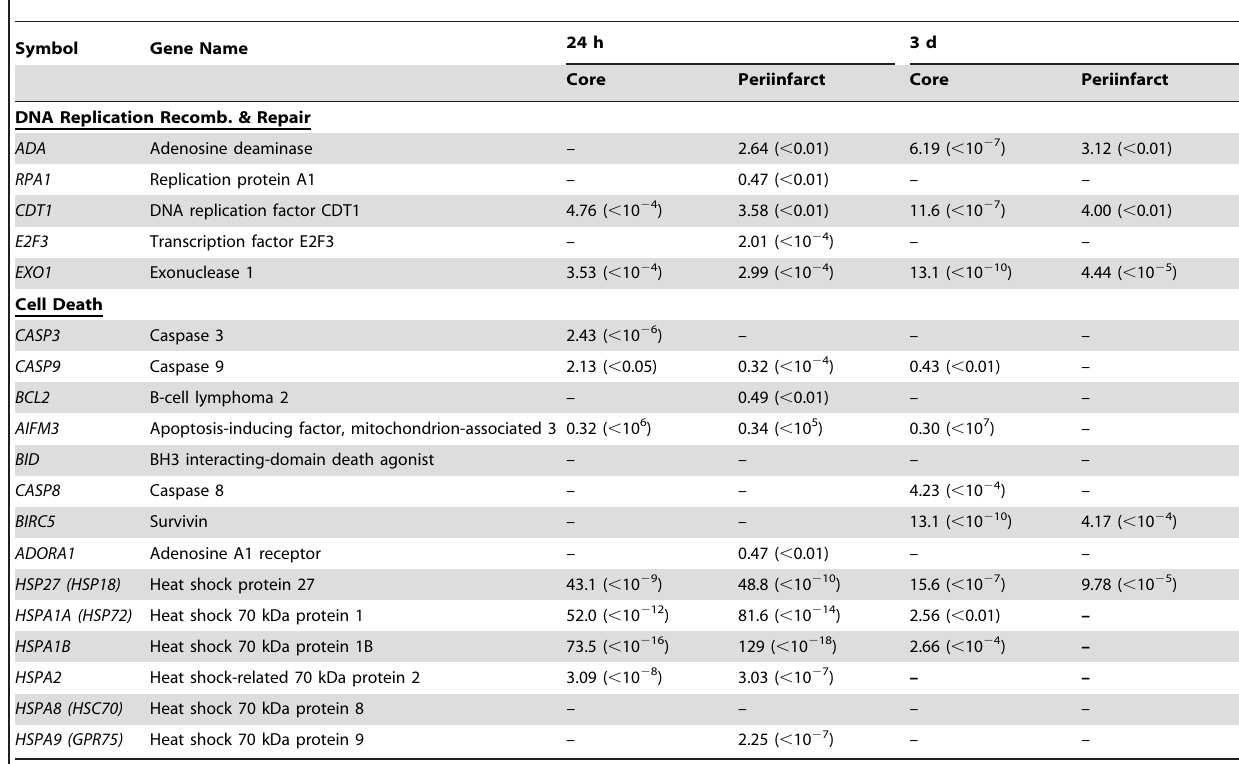
Table 6. Regulation of DNA replication, recombination & repair and also cell death-associated genes in the core and periinfarct after permanent focal cerebral